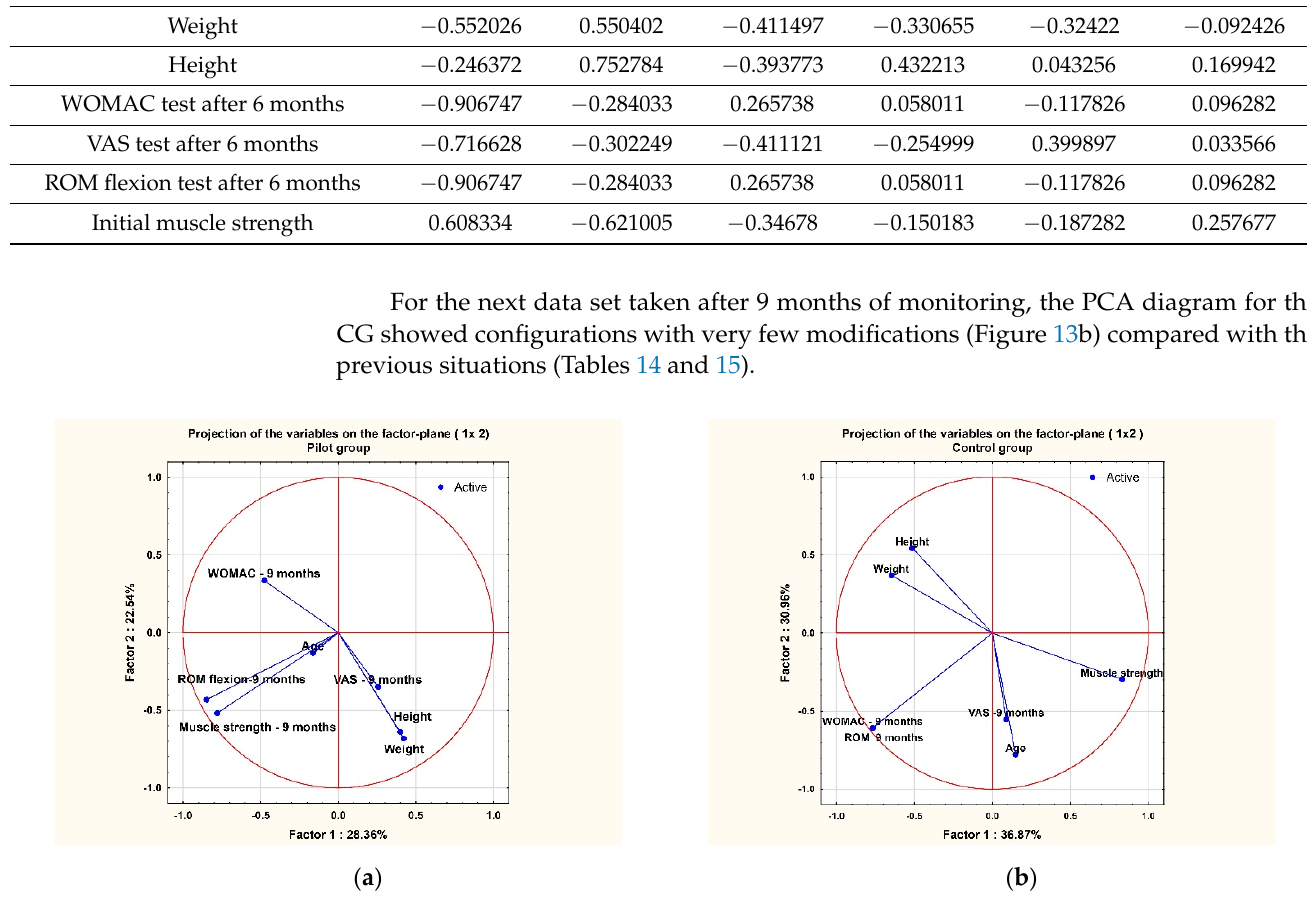
Figure 13. PCA analysis results for the ( a ) pilot group and ( b ) control group at 9 months. Table 14. Factor coordinates of the variables based on correlations with the pilot group (PG) after 9 months.